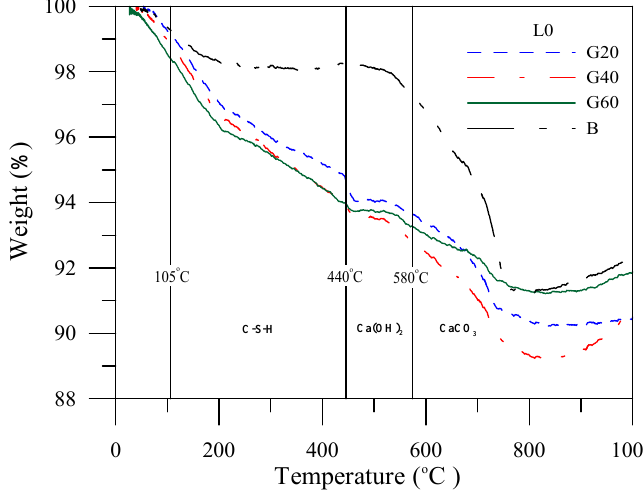
Figure 15. Weight loss of the specimens with slag admixture prior to leaching vs. temperature change.